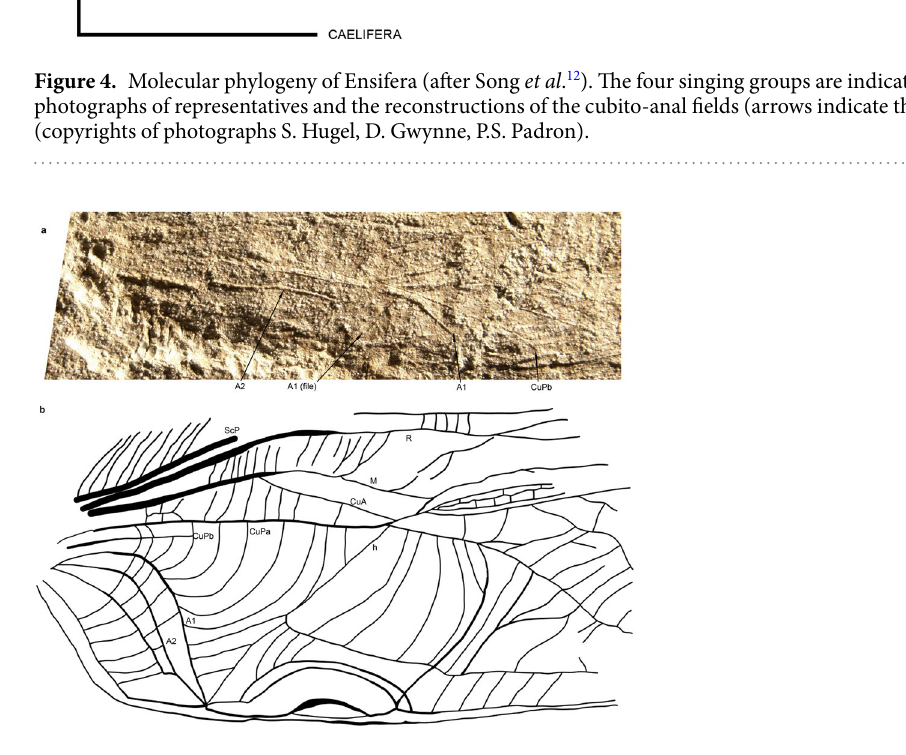
Figure 5. Wing venation interpretations. ( a ) Mesoedischia obliqua Gorochov, 1987, holotype PIN 2240/4074, Triassic, Kyrgyzstan, photograph (copyright A. Rasnitsyn); for the reconstruction of tegmen see ref. 28. ( b ) Reconstruction of tegment of a Grylloidea indet., MNHN.F.A57514, Torcian, Bascharage, Grand-Duché du Luxembourg (copyright A.